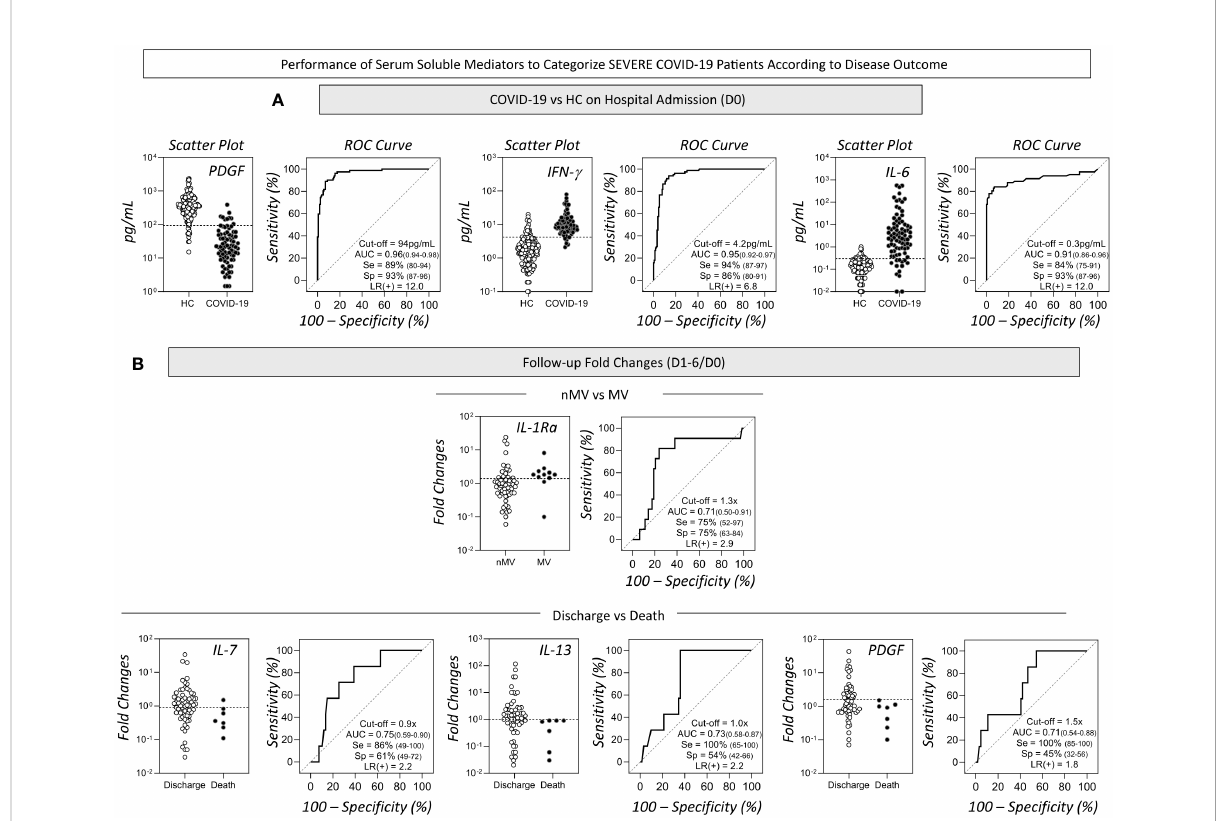
FIGURE 7 Performance of serum soluble mediators to categorize severe COVID-19 patients according to disease outcome. The detailed performance of pre-selected serum soluble mediators to categorize severe COVID-19 patients were assessed employing additional indices to substantiate the use of putative immunological parameters for complementary diagnosis and prognosis purposes. Scatter plot distribution of individual values and Receiver Operating Characteristic (ROC) curve analysis were constructed for each soluble mediator and the performance indices (area under the ROC curve - AUC, Sensitivity-Se, Speci fi city-Sp and Likelihood ratio - LR) are provided in the fi gure. (A) The serum concentration of PDGF, IFN- g and IL-6 (pg/mL) quanti fi ed upon admission (D0) displayed higher performance to classify COVID-19 patients (black circles, n=82) from non-infected pre-pandemic Healthy Controls (HC, white circle, n=164). Speci fi c cut-offs were de fi ned for each selected soluble mediator as follows: PDGF (94pg/mL); IFN- g (4.2pg/mL) and IL-6 (0.3pg/mL). (B) The baseline fold change (D1-6/D0) of IL-1Ra presented higher performance to classify Non-Mechanical Ventilation (nMV, white circle, n=71) from Mechanical Ventilation (MV, black circle, n=11). IL-7, IL-13 and PDGF showed higher performance to classify Discharge (white circle, n=75) from Death (black circle, n=7). Speci fi c cut-offs were de fi ned for the fold change (D1-6/D0) of each selected soluble mediator as follows: IL-1Ra (1.3x); IL-7 (0.9x) and IL-13 (1.0x) and PDGF